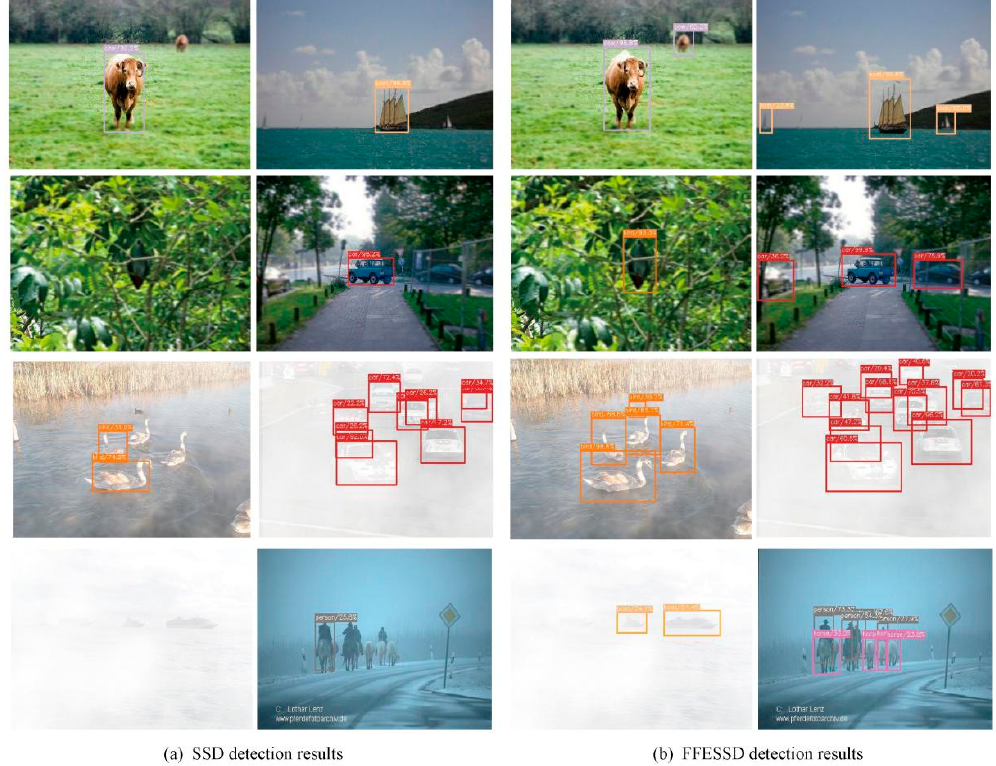
Figure 5. Fuzzy target detection examples on the Pascal VOC 2007 test dataset with the SSD300 / FFESSD300 model. ( a ) The images are the results of the SSD and ( b ) the images are the results of the FFESSD.